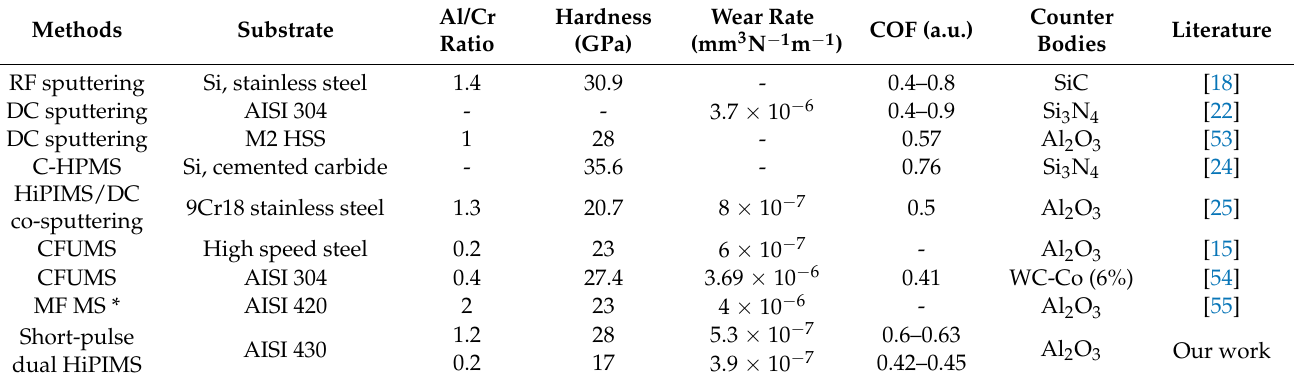
Table 3. Mechanical and tribological properties of magnetron-sputter-deposited CrAlN